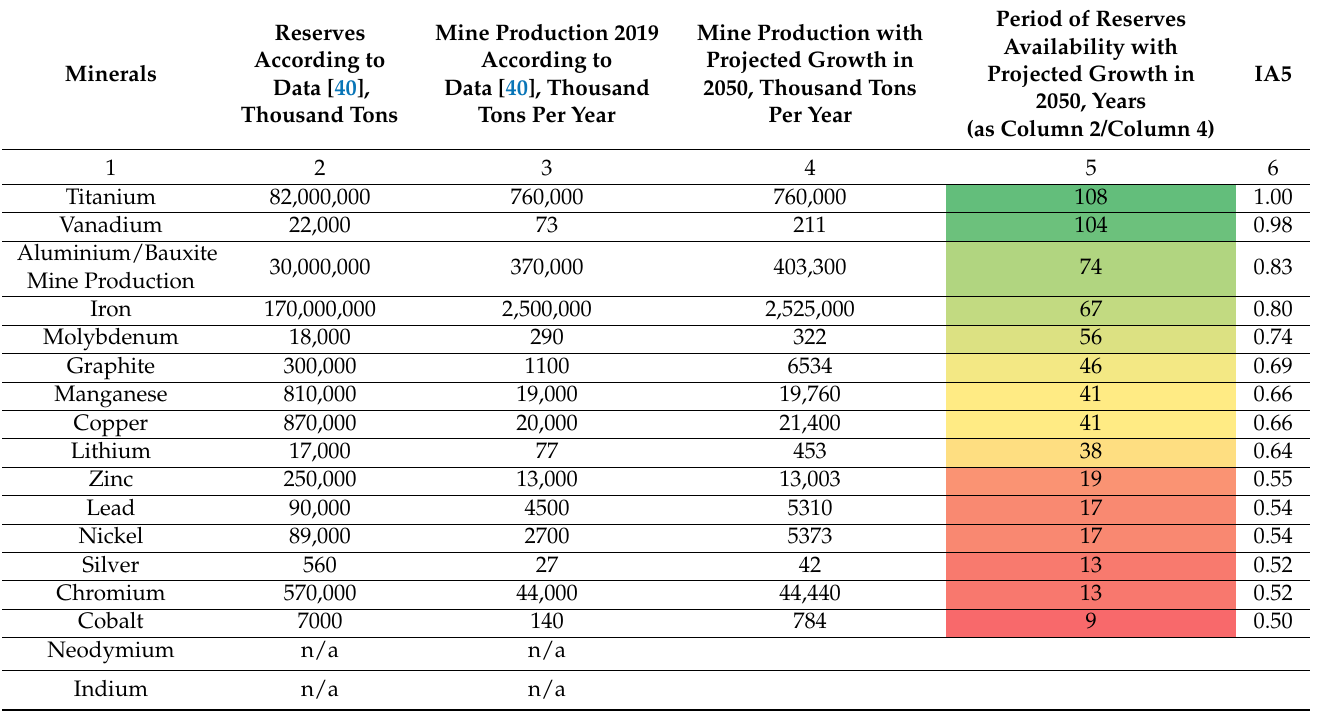
Table A5. Mineral ranking by the period of reserves availability.